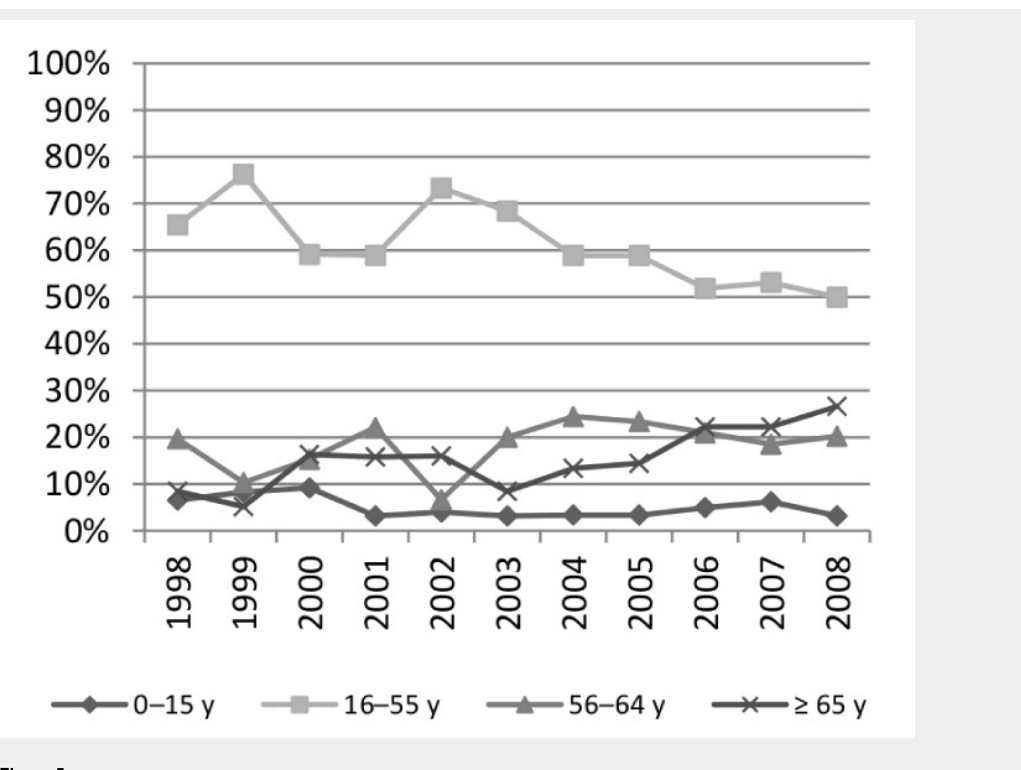
Age distribution of the donors per year, displaying the percentage of donors within the age range of 0 to 15 years, 16 to 55 years, 56 to 64 years and 65 years and above.